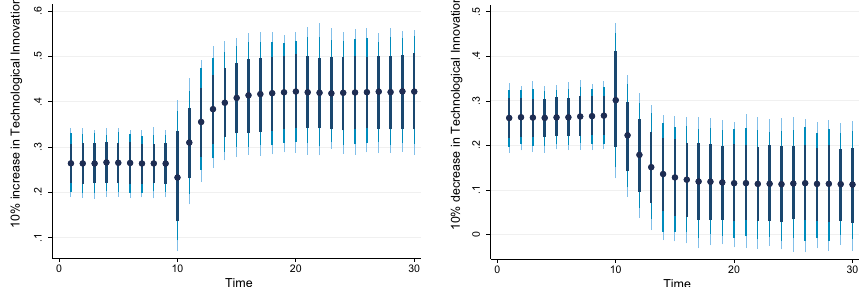
Fig. 8 The Impulse Response Plot for Technological Innovation and CO 2 Emissions. Figure 8 presents an increase and a decrease by 10% in technological innovation and its effect on CO 2 emissions where dots denote average prediction value. The dark blue to light blue line shows 75, 90, and 95% confidence interval,